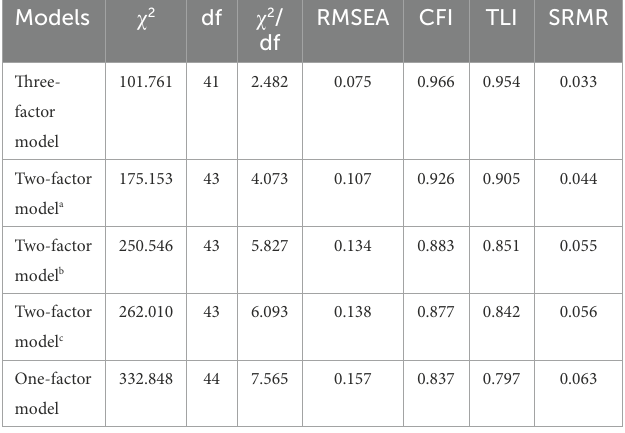
TABLE 2 The results of confirmatory factor analyses for collaborative HRM. Models